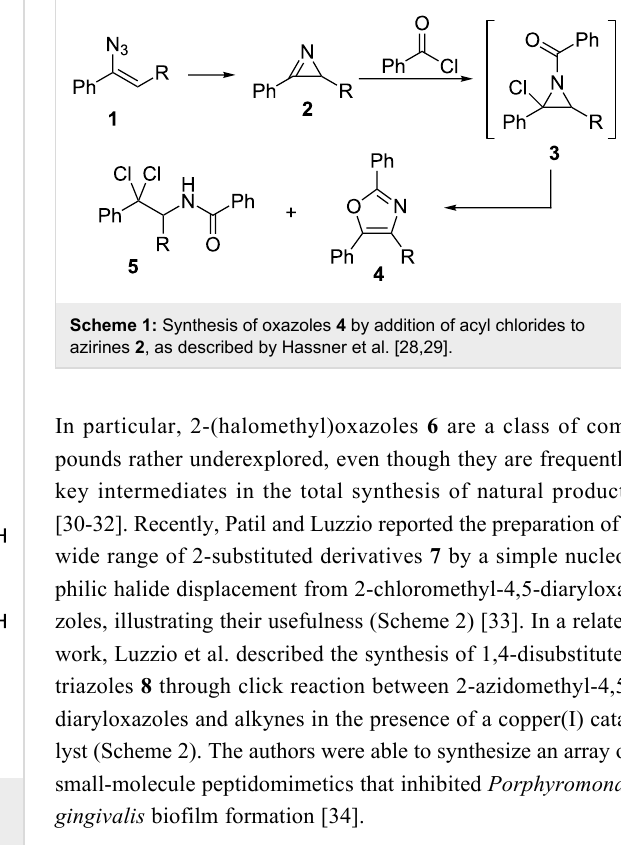
tandem processes (Figure 1d) [10-13]. A classical example is the preparation of pyridoxine (a form of vitamin B6) using this approach